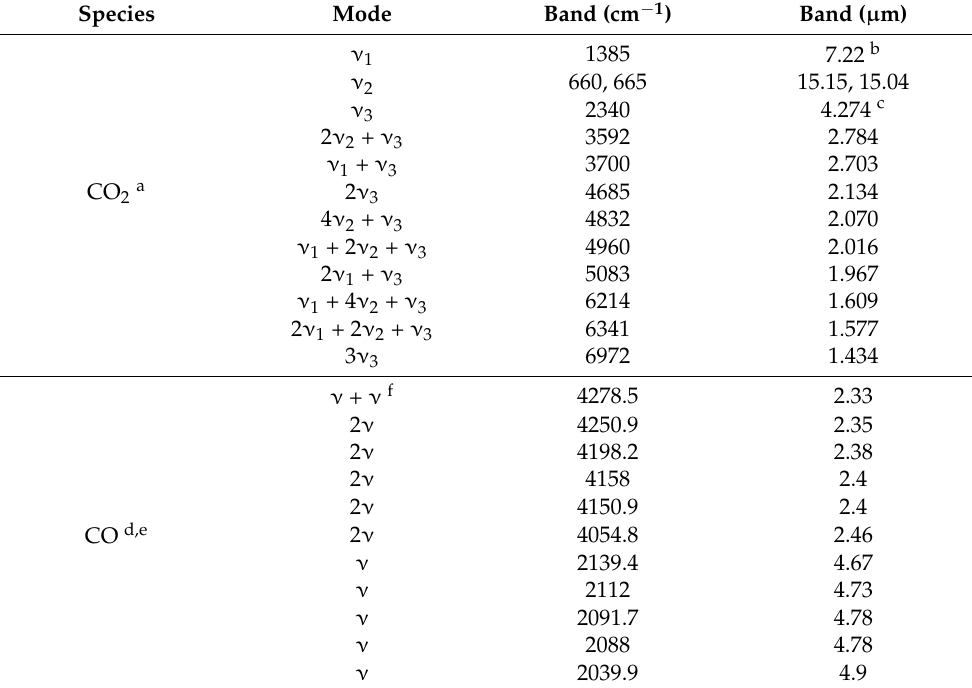
Table 5. Prominent spectral bands in the IR wavelengths and respective vibrational modes.